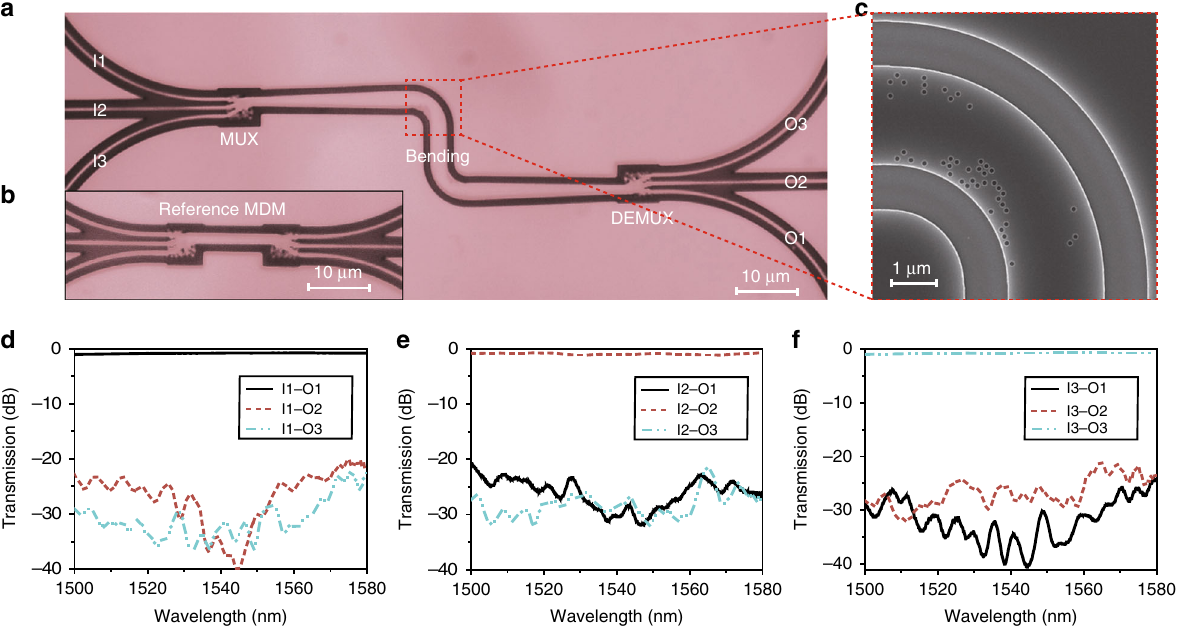
Fig. 2 Fabrication and experimental results of the digital meta-structure (DMS)-based bending. a The top-view microscope image of the mode-division multiplexing (MDM) circuit consisting of multiplexer (MUX), bending, and demultiplexer (DEMUX). b The microscope image of the reference circuit: back to back (DE)MUXs. c The scanning electron microscope image of the fabricated bending. d ‒ f The measured transmission spectra of the MDM circuit for the optical wave launched from I1 (TE 0 mode), I2 (TE 1 mode), and l3 (TE 2 mode),